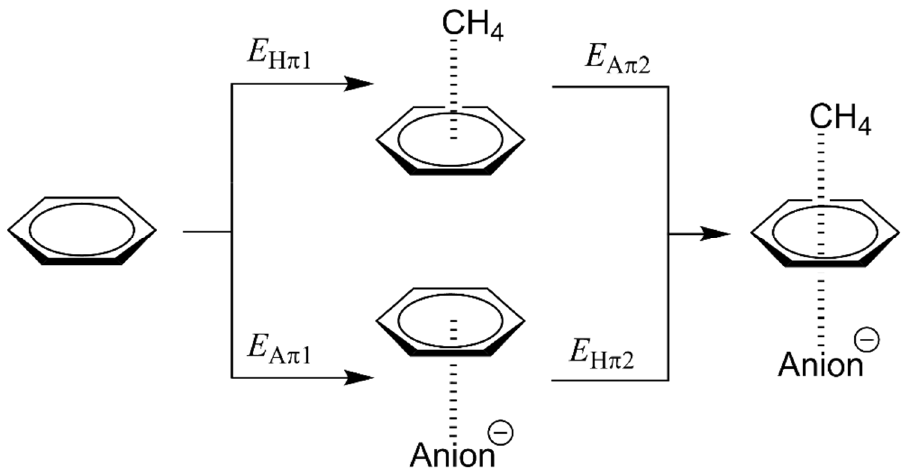
Figure 3. Schematic representation of the two routes to form the CH/ π –Anion complexes that allows computation of the Δ E H π and Δ E A π differences. computation of the ∆ E H π and ∆ E A π